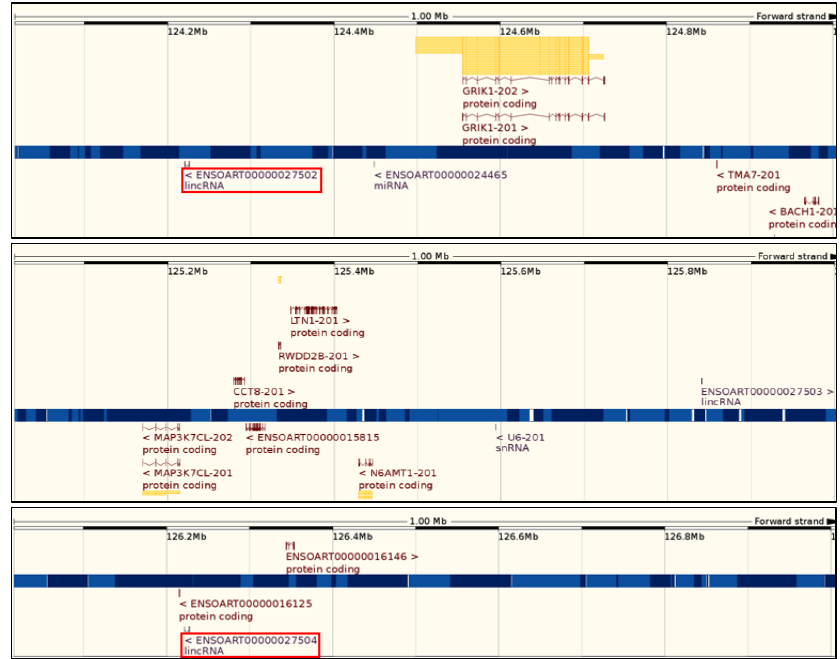
Figure 7. Sequence analysis of the sheep chromosome 1 region reveals the presence of more long intergenic non-coding RNA (lincRNA) genes within the KRTAP cluster region than in its flanking regions. The KRTAP cluster, spanning from KRTAP11-1 to KRTAP24-1 , is indicated by the green bar. The lincRNA genes, identified based on the sheep assembly sequence Oar_rambouillet_v1.0 (GCA_002742125.1) using Ensembl (http://asia.ensembl.org/; accessed on 21 June 2021), are marked in red boxes.